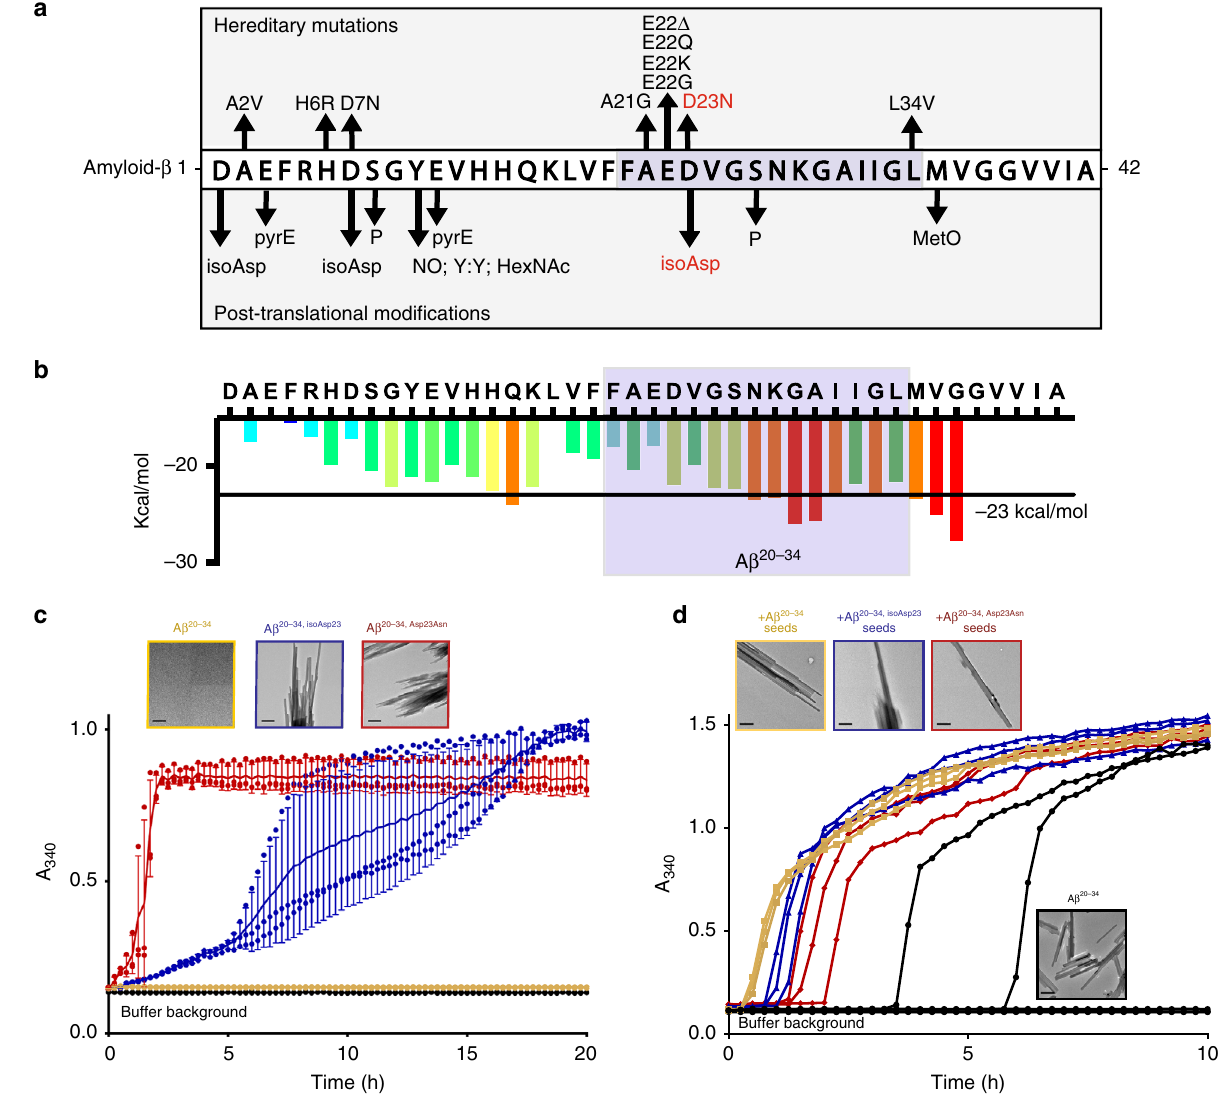
Fig. 1 L-isoAsp in A β 20 – 34 accelerates fi ber formation and can seed native segment. a Sequence of human A β including known early-onset hereditary mutations and posttranslational modi fi cations (pyrE pyroglutamate, P phosphorylation, NO nitration, Y:Y dityrosine crosslink, HexNAc glycosylation, MetO oxidation) . b ZipperDB 22 amyloid propensity pro fi le for the human A β sequence with the A β 20 – 34 sequence highlighted in light blue. c 1.6 mM of A β 20 – 34 , A β 20 – 34, Asp23Asn , and A β 20 – 34, isoAsp23 peptide aggregation was monitored by turbidity at 340 nm. Each data point is shown as a round symbol, the solid line represents the mean value, and error bars represent SD of three replicates. Transmission electron micrographs of aggregates are shown at the top left of the graph, scale bars represent 0.5 μ m in each image. d Aggregation of 3.2 mM A β 20 – 34 in 50 mM Tris, pH 7.5, 150 mM NaCl, and 1% dimethyl sulfoxide was monitored by turbidity at 340 nm alone (black lines) or with 10 µ M pre-aggregated seeds of A β 20 – 34 (yellow), A β 20 – 34, isoAsp23 (blue), and A β 20 – 34,Asp23Asn (red). Each line represents a replicate well. Transmission electron micrographs of aggregates are shown at the top left of the graph; scale bars shown at the lower left represent 0.5 μ m in each image. Source data are provided as a Source Data fi